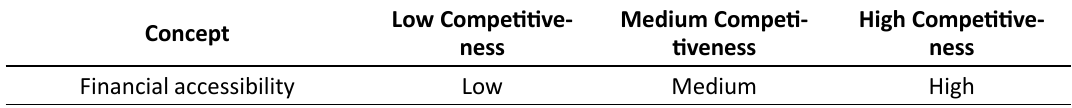
Table 3: Characteristics of IKM by